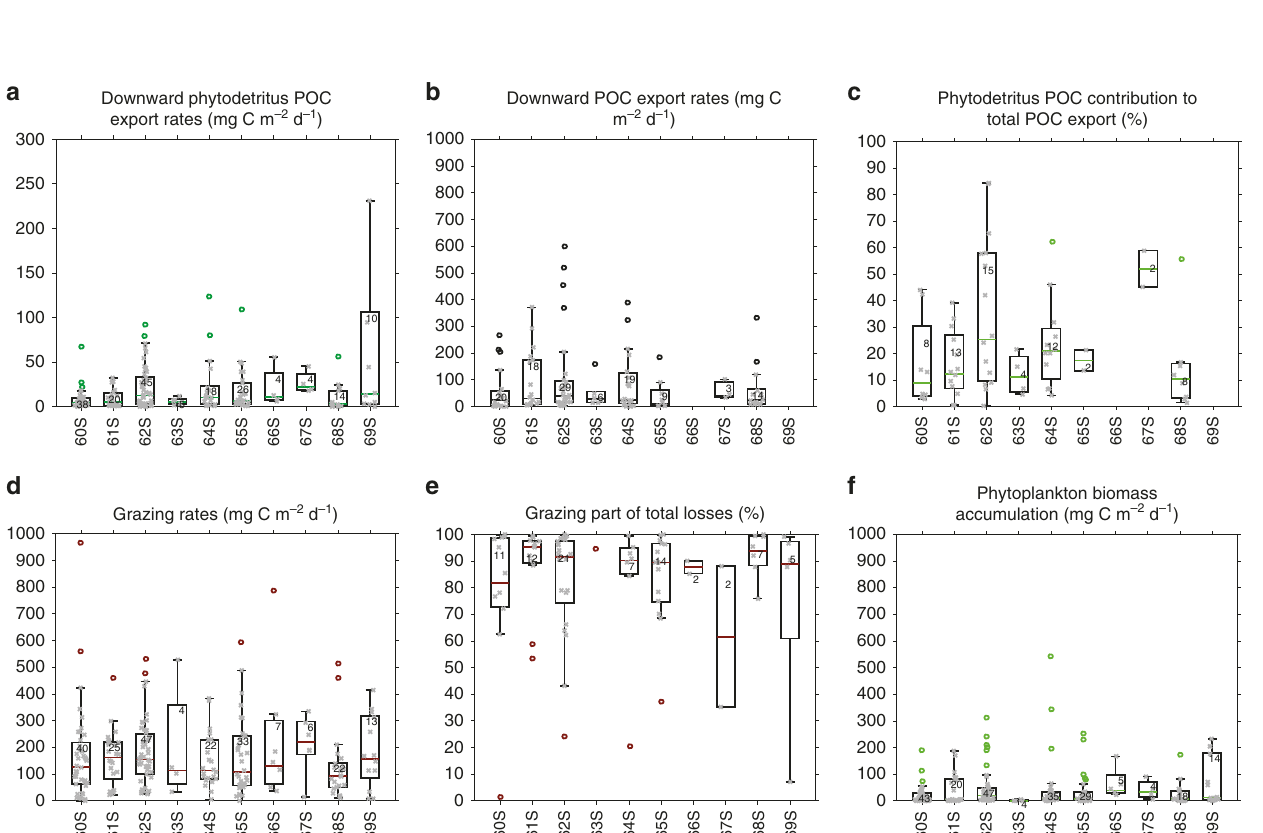
Phytodetritus POC export and grazing average (Avg) and standard deviation (stdev) are given in mgCm − 2 d − 1 . The contribution of grazing to the total fate of phytoplankton is given as % grazed.